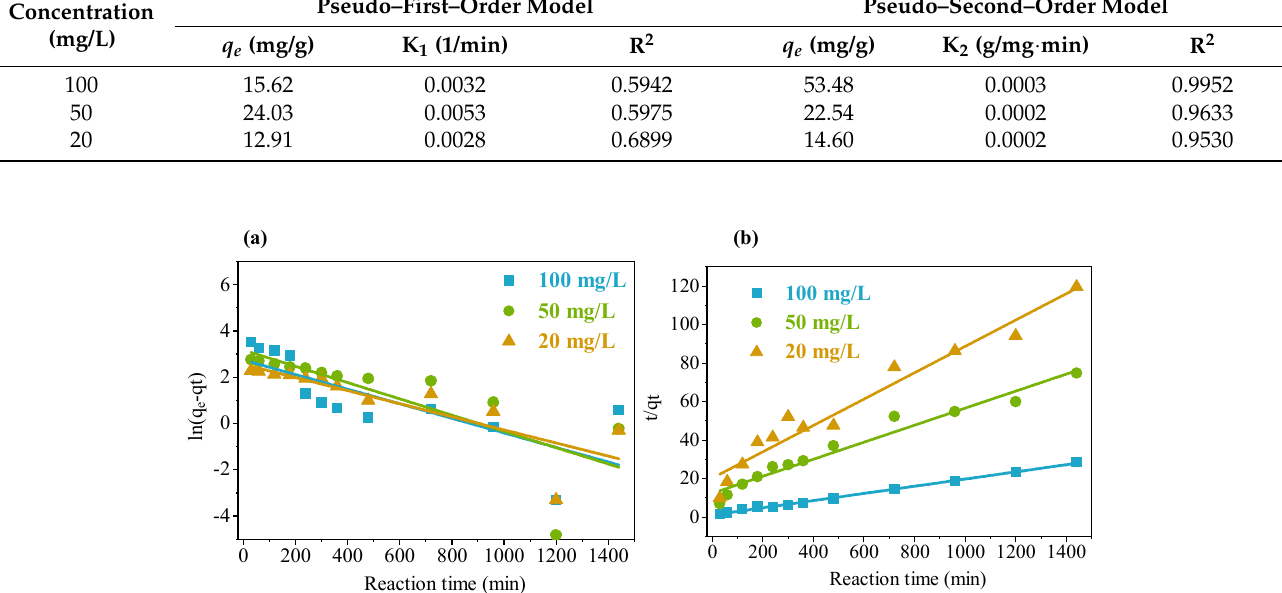
Table 1. The parameters for kinetic models of Cr(VI) removed by Mxene–CS.